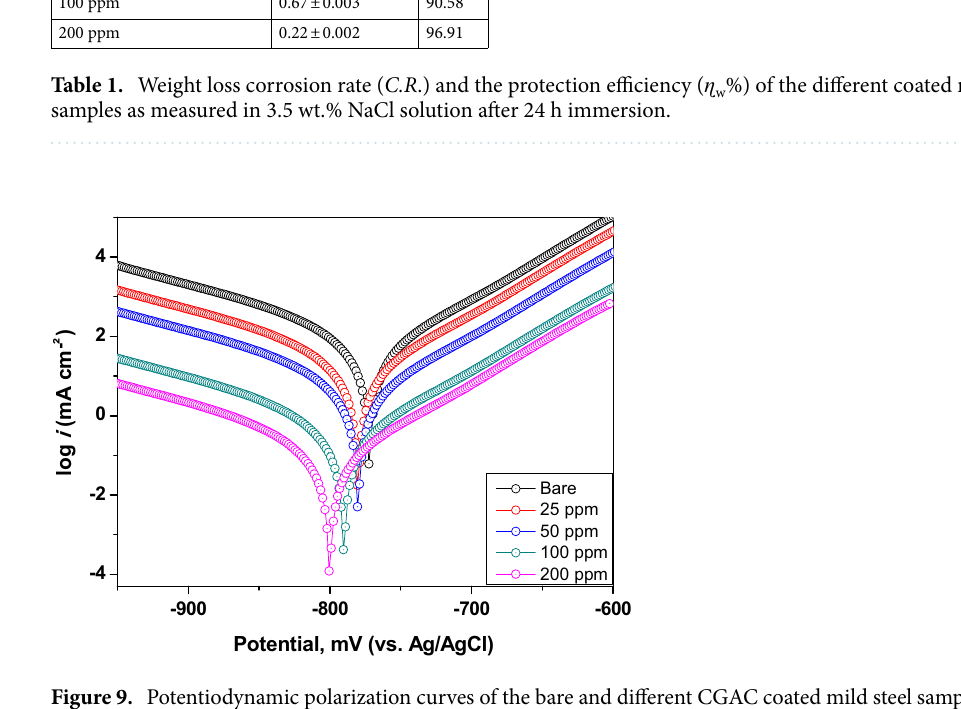
Figure 9. Potentiodynamic polarization curves of the bare and different CGAC coated mild steel samples in 3.5 wt.% NaCl solution at 25